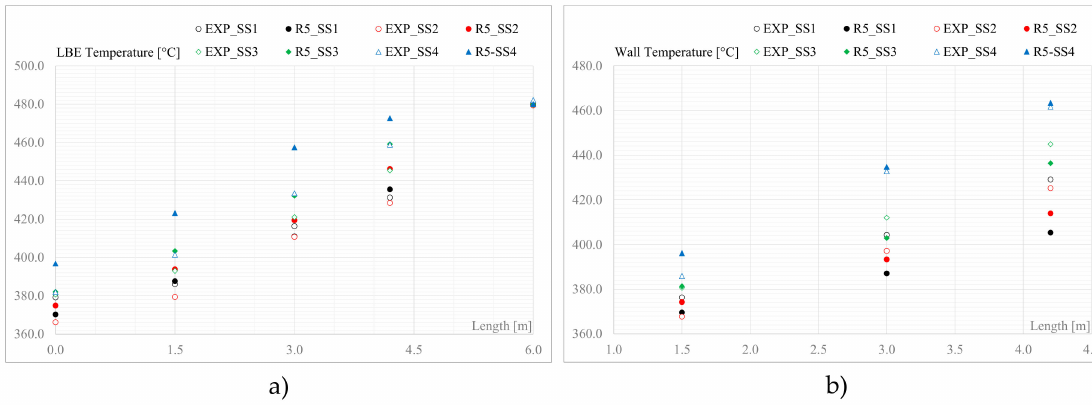
Figure 15. EF-T5, exp. vs. RELAP5-3D: ( a ) SG LBE bulk temperatures; ( b ) wall temperatures. The thermal conductivity of the HERO double-wall gap could also be a source of uncertainty. In fact, the thermal conductivity of the AISI316L powder + He used to fill the gap is a function of the temperature and is influenced by several factors, i.e., powder compaction, grain size and growth, and thermal cycling [39]. Dedicated experimental campaigns performed at ENEA Brasimone R.C. allowed the experimental correlations reported in [40] to be derived. Such correlations were taken as reference for the simulations since they were used for the HERO SGBT